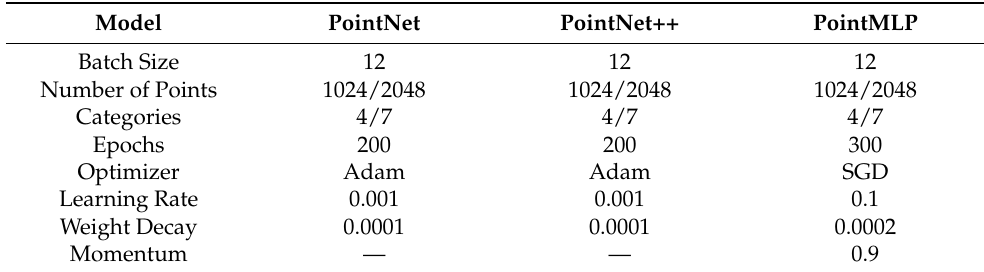
Table 2. Summary of hyperparameters for deep learning